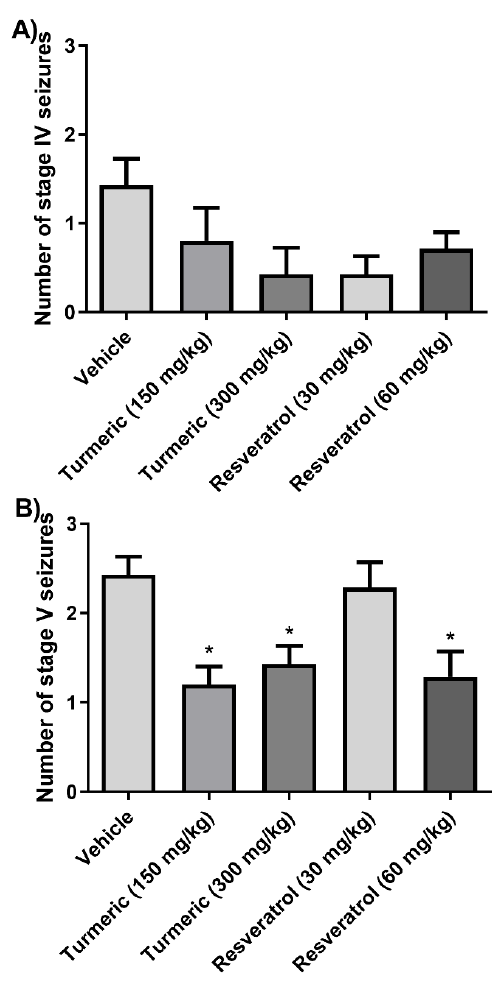
Figure 4. Number of ( A ) phase IV and ( B ) phase V generalized seizures. The 150 and 300 mg/kg of turmeric and 60 mg/kg of resveratrol groups decreased the number of phase V generalized seizures compared to the vehicle group. Data were analyzed by one-way ANOVA, followed by Tukey’s multiple comparison test. Data are expressed as the mean ± standard error. * p < 0.05 vs. the vehicle group.